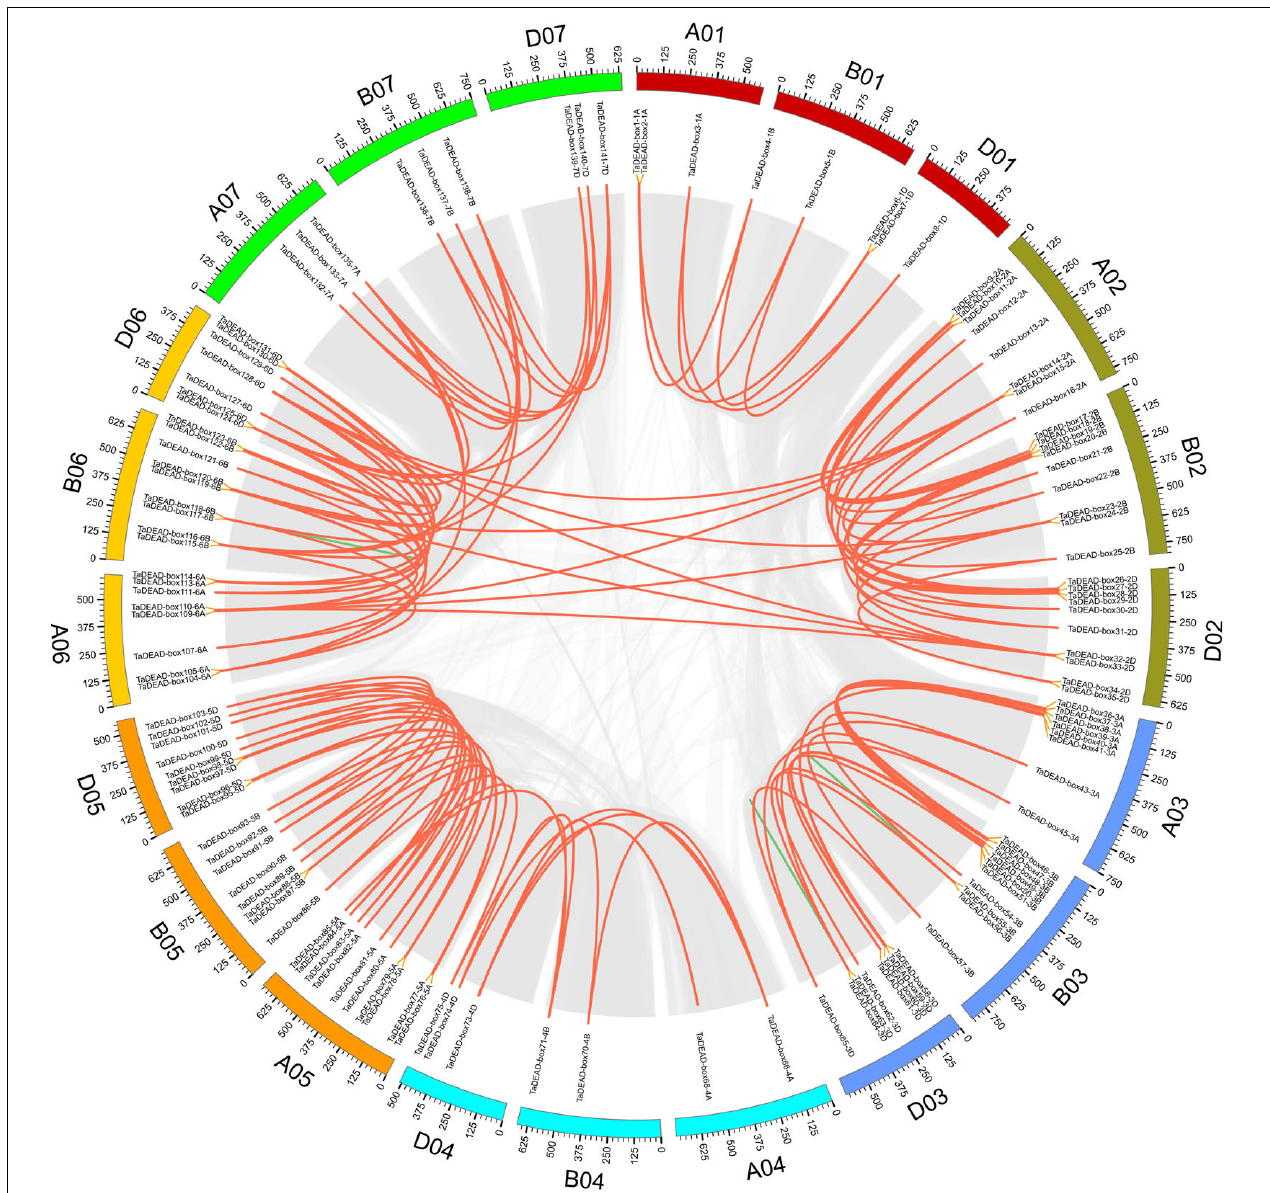
FIGURE 3 | Distribution and duplication events of TaDEAD-box genes across wheat genome. All TaDEAD-box genes were mapped to 21 wheat chromosomes in a circle using Circos, and WGD/segmental and tandem duplications were mapped to their respective locations. Gray regions indicate all synteny blocks within the wheat genome, red and green lines, respectively, represent WGD/segmental and tandem duplications. The chromosome numbers are marked inside of the